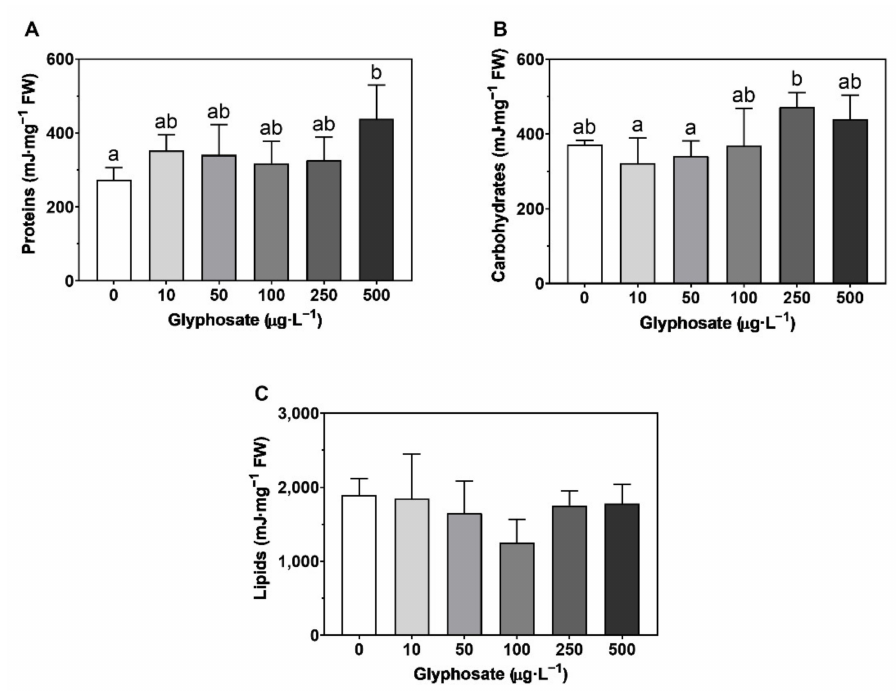
Figure 9. Energy availability: ( A ) carbohydrates; ( B ) proteins; ( C ) lipids in Ulva lactuca following a 48-h exposure to glyphosate-based herbicide formulation in different concentrations (mean ± s.d., n = 5, different letters indicate significant differences at p <